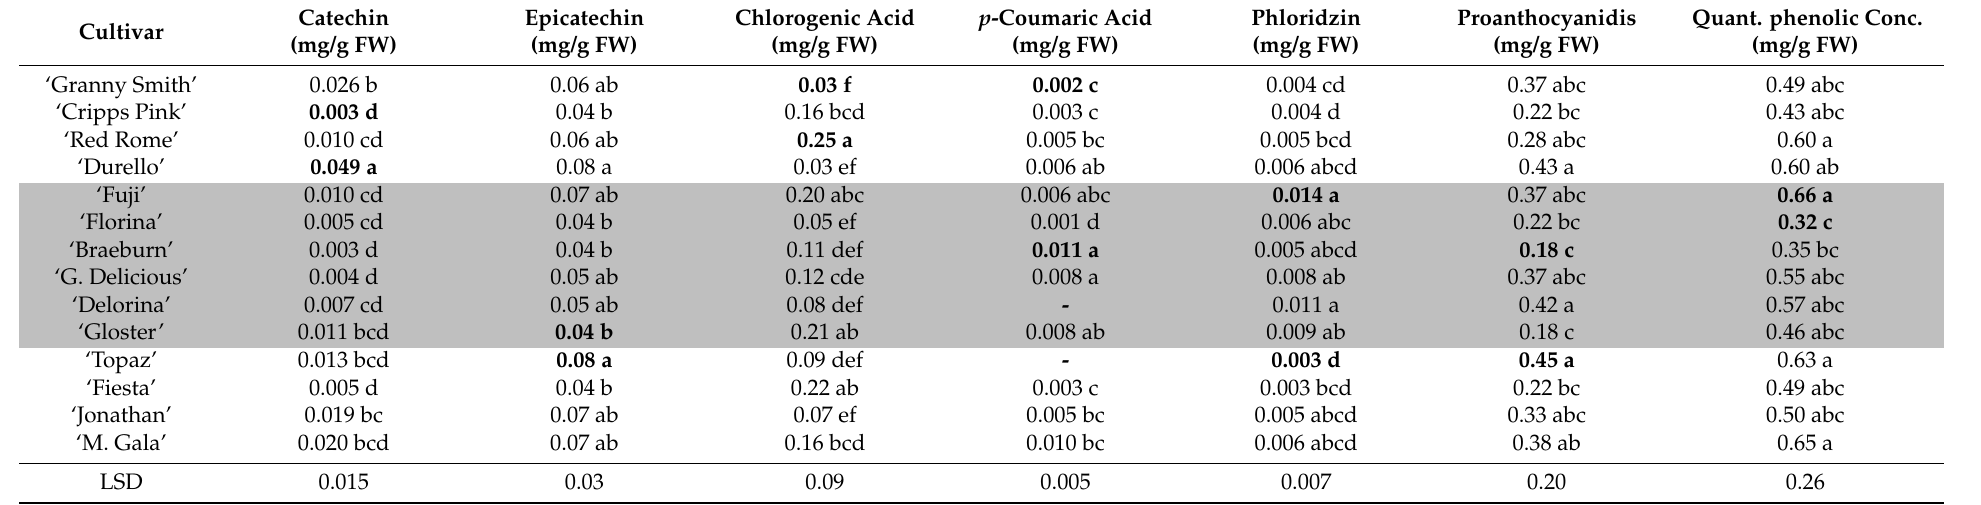
Table 2. Phenolic compound concentrations within each cultivar (averaged from all time points) and quantified phenolic concentration (QPC). Cultivars are presented in the same order as in Figure 1 based on their level of flesh browning: minimal browning (first 4 cultivars), moderate browning (the portion of table shaded in gray), and severe browning (last 4 cultivars). Cultivar ‘Granny Smith’ ‘Red Rome’